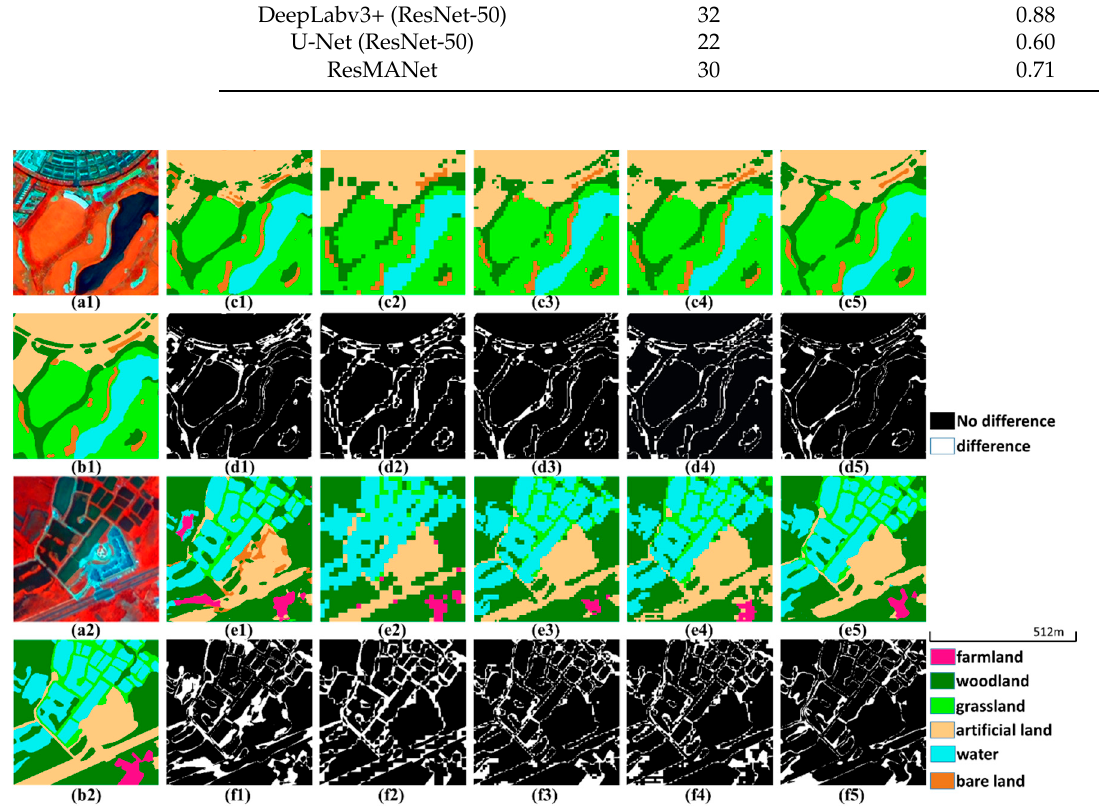
Figure 13. Prediction examples in the validation set of dataset B. ( a1 , a2 ) False color images composited by the NIR, G, and B bands. ( b1 , b2 ) Ground truth images. ( c1 – c5,e1 – e5 ) Predictions of U-Net, PSPNet (ResNet-50), DeepLabv3+ (ResNet-50), U-Net (ResNet-50) and ResMANet. ( d1 – d5 , f1 – f5 ) Corresponding difference maps.